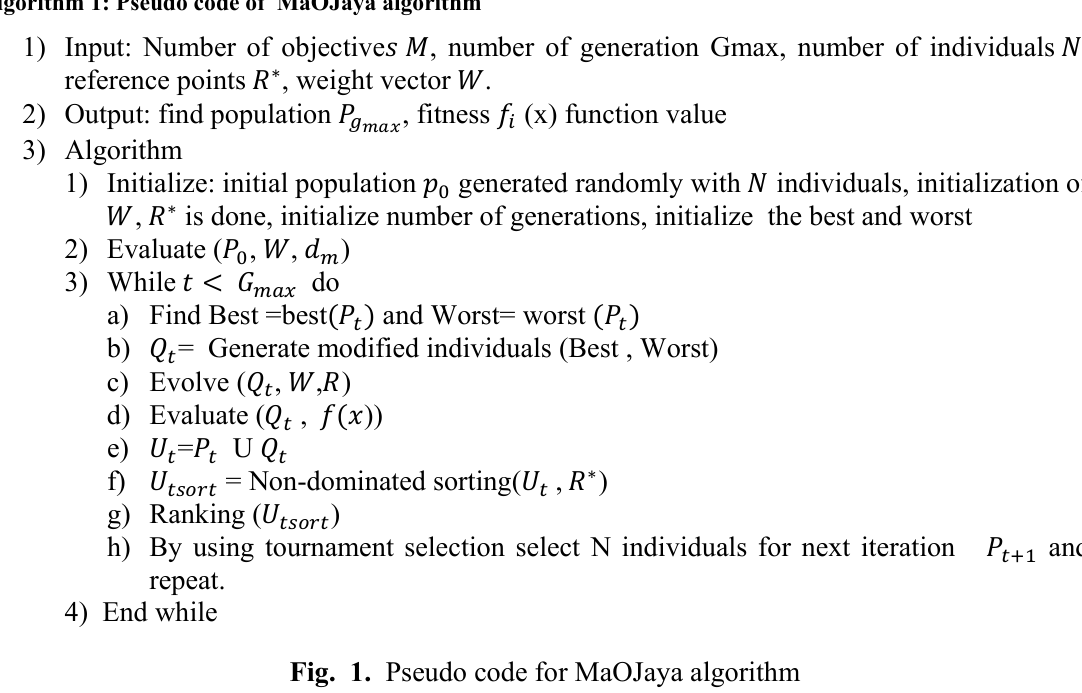
Algorithm 1: Pseudo code of MaOJaya algorithm